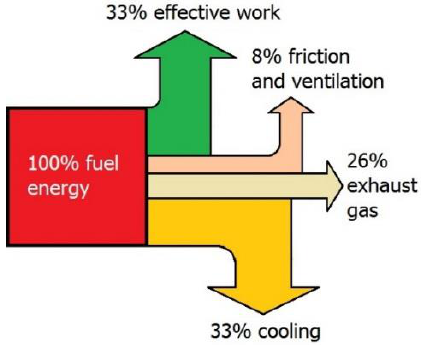
Fig. 4. Energy balance for biogas engine